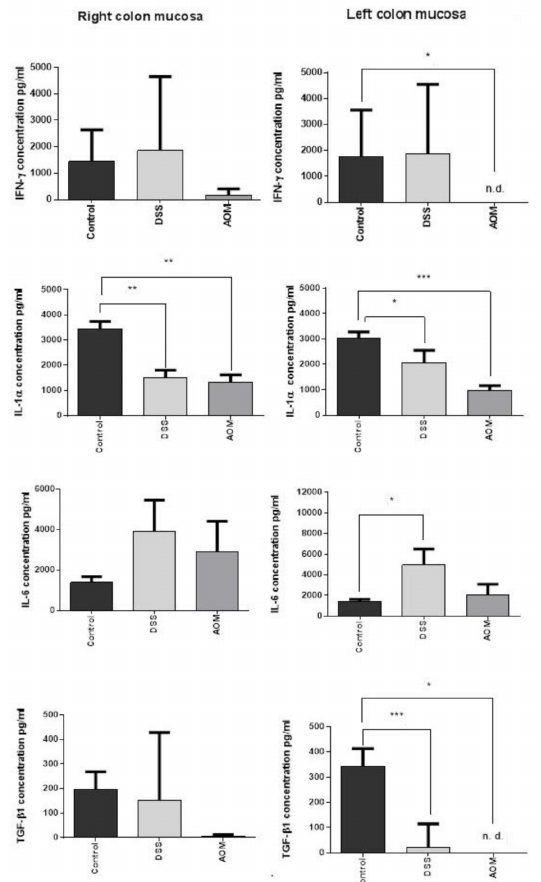
Figure 6. Cytokine production in the full colon mucosa of DSS- or AOM-induced rats at 1 month from the end of treatments. The production of all measured cytokines in the right and left colon mucosa showed similar patterns. The significant differences were found in the IL-1 α production in both left and right colon between control and treated rats. Increase of IL-6 was particularly significant in the left colon mucosa after DSS colitis induction. Decrease of TGF- β 1 was relevant after AOM in all colon mucosa and significant after both treatments in the left colon mucosa, the part of the colon known to be more affected by ulcerative colitis and cancer occurrence. IFN- γ production was slightly increased after DSS (not significant), whereas it was inhibited in the right colon mucosa and especially in the left colon mucosa (not at measurable levels) after AOM pro-carcinogenic treatment. ELISA values are expressed in pg/mL. Significance by Kruskal–Wallis test: * for p < 0.05, ** for p < 0.01, and *** for p <